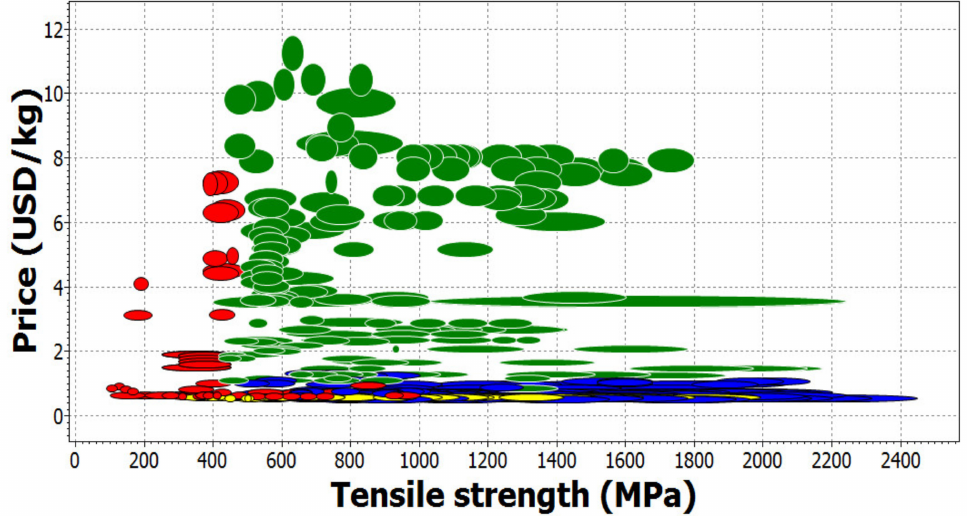
Figure 4. Example of a material chart obtained in the CES EduPack software.